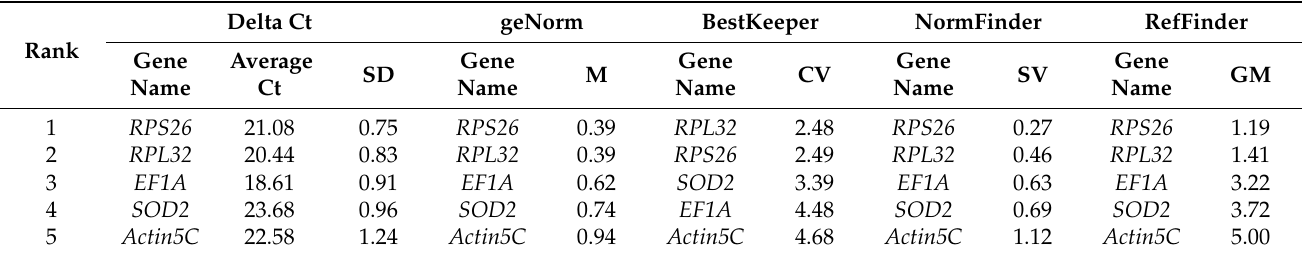
Table 1. Expression stability ranking of the selected candidate reference genes using Delta Ct, geNorm, BestKeeper, NormFinder, and